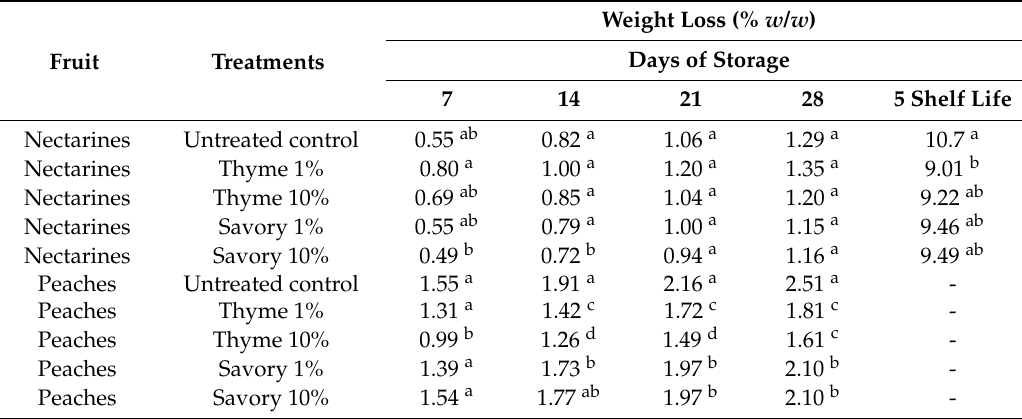
Table 5. Weight loss (% w / w ) of nectarines ‘Sweet Red’ and peaches ‘Vista